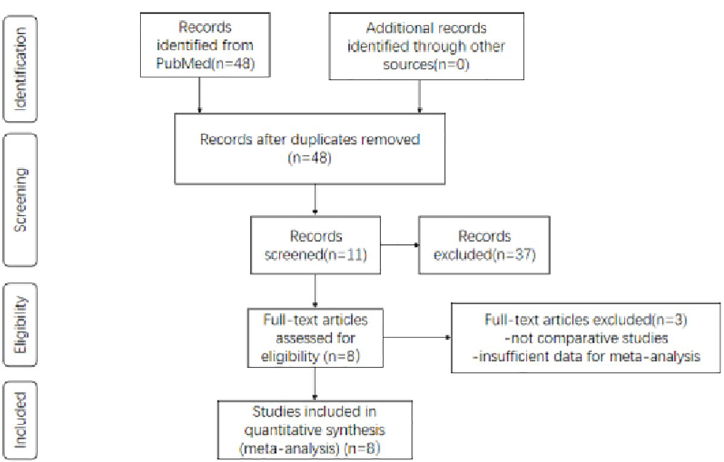
Fig 1. The flowchart of the research selection. A total of eight potentially relevant articles were identified from our search strategies across all databases and systematic review reference lists.